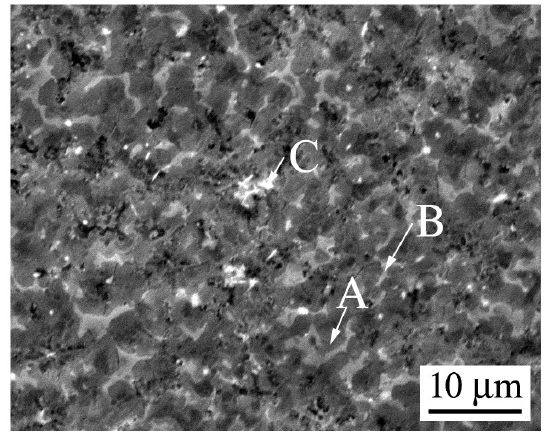
Figure 3. Scanning electron micrograph of spray-casted AZ91D+0.75Ce alloy.